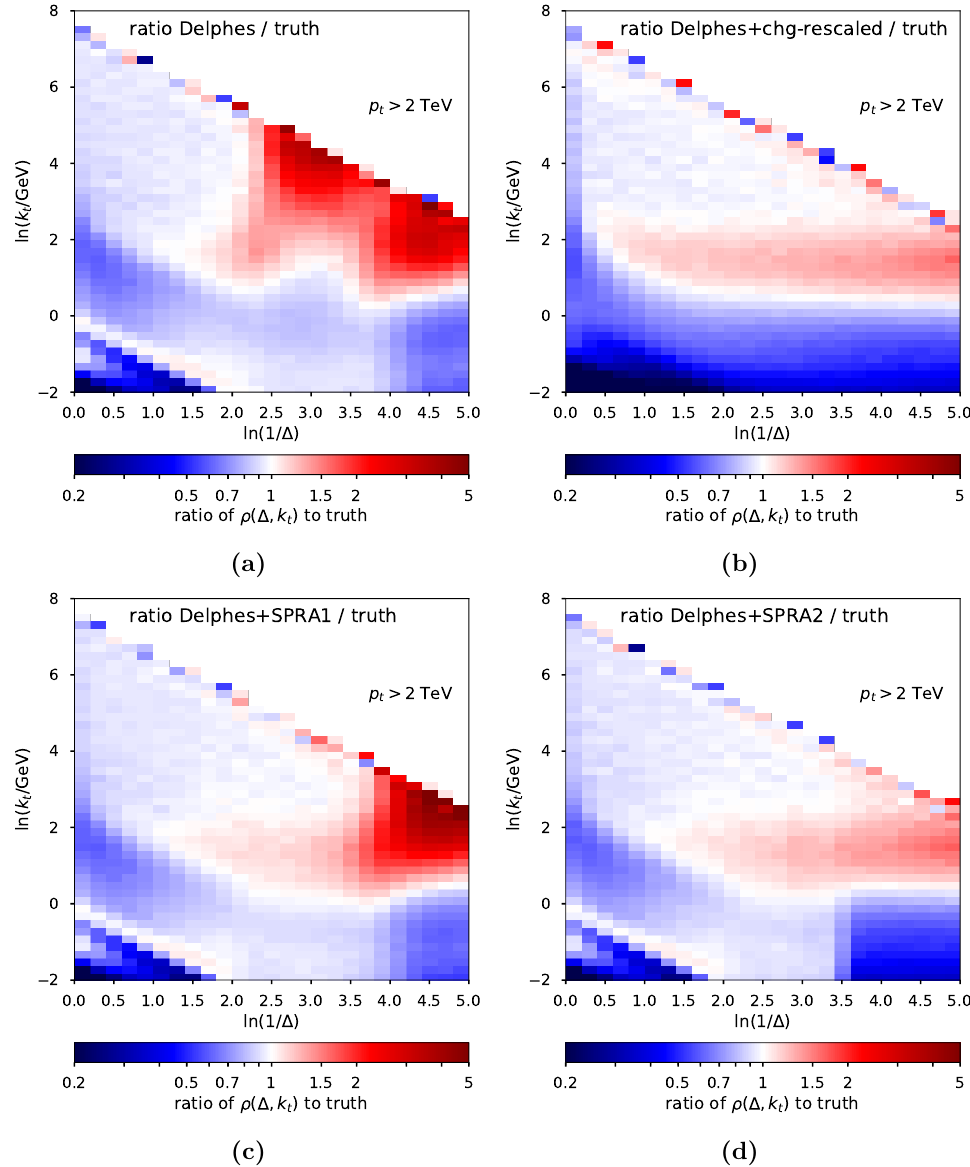
Figure 18. Ratio of detector-level Lund-plane densities to the truth density. (a) With Delphes’ particle (cid:13)ow algorithm. (b) Delphes particle (cid:13)ow supplemented with charged rescaling (after rescal- ing, neutral particles are discarded). (c,d) Delphes particle (cid:13)ow supplemented with SPRA1, SPRA2 respectively. The generation and selection of jets is as described in section 3.4, using the dijet pro- cess, selecting jets with the requirement p t > 2 TeV, j y j < 2 :